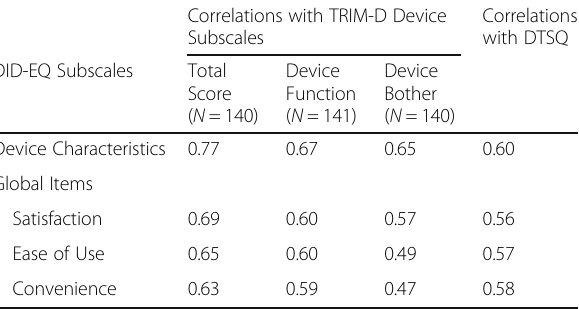
Table 4 Convergent Validity: Spearman Correlations of the